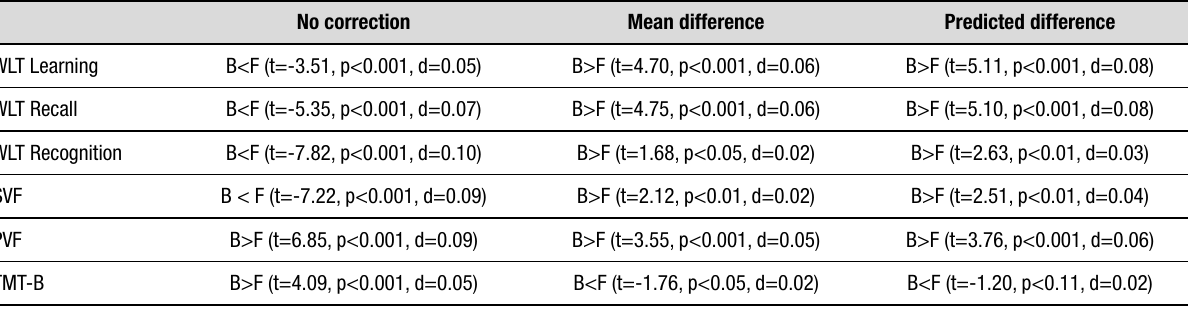
Table 3. Within-subject t-test comparing the baseline score with follow-up no correction, mean difference correction, and predicted difference